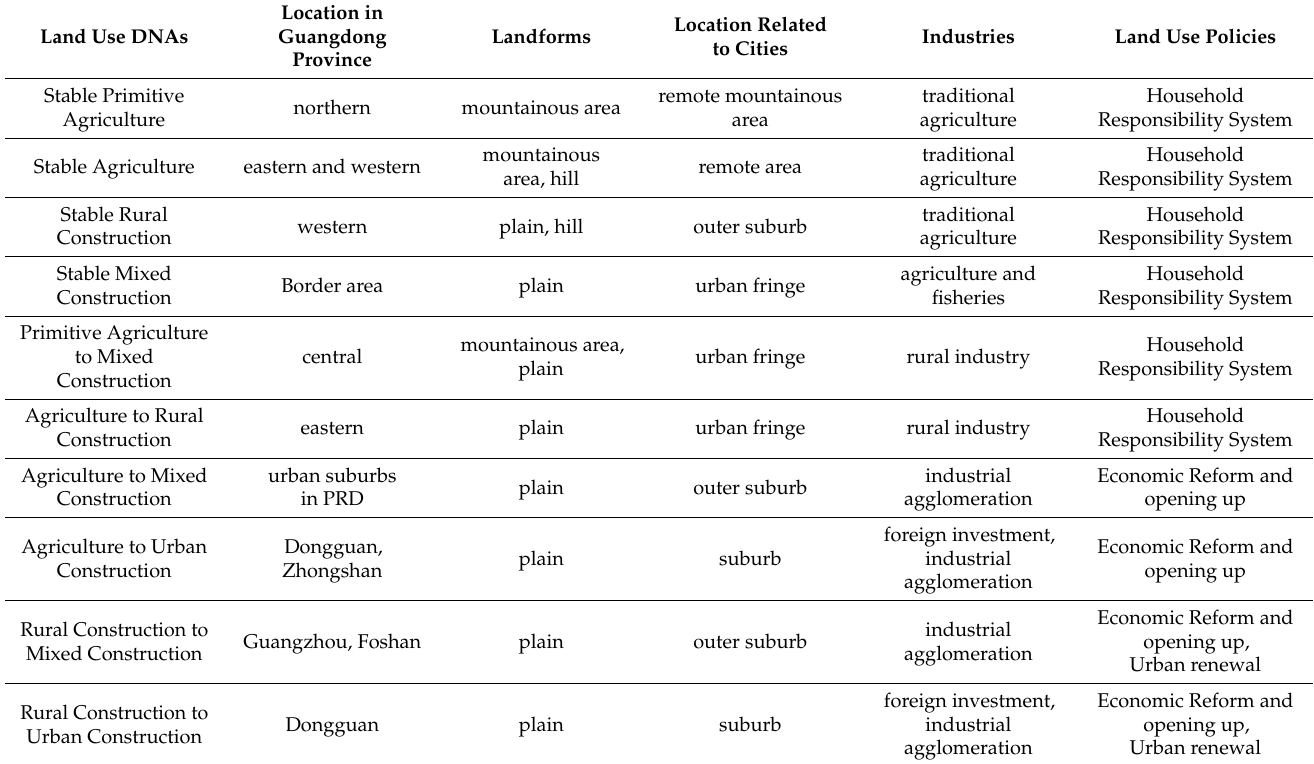
Table 3. Potential driving forces leading to 10 types of land use sequences of